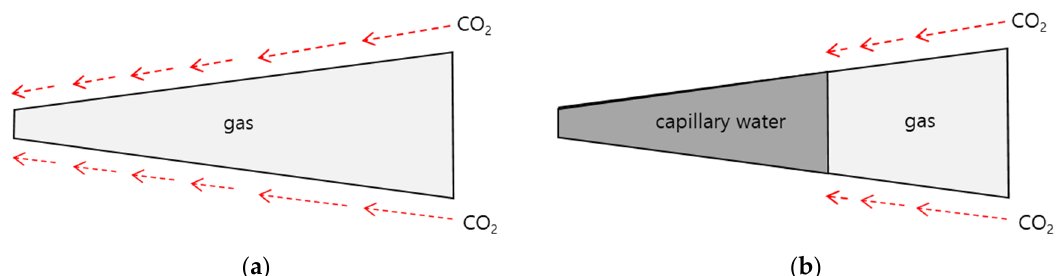
Figure 3. Comparison of CO 2 apparent diffusivity and CO 2 effective diffusivity. ( a ) Apparent pore system; ( b ) Effective pore system.